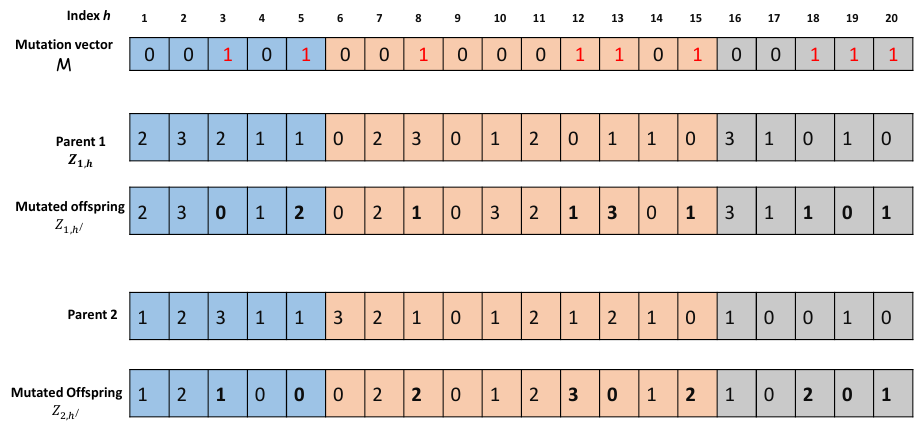
Figure 8. Uniform